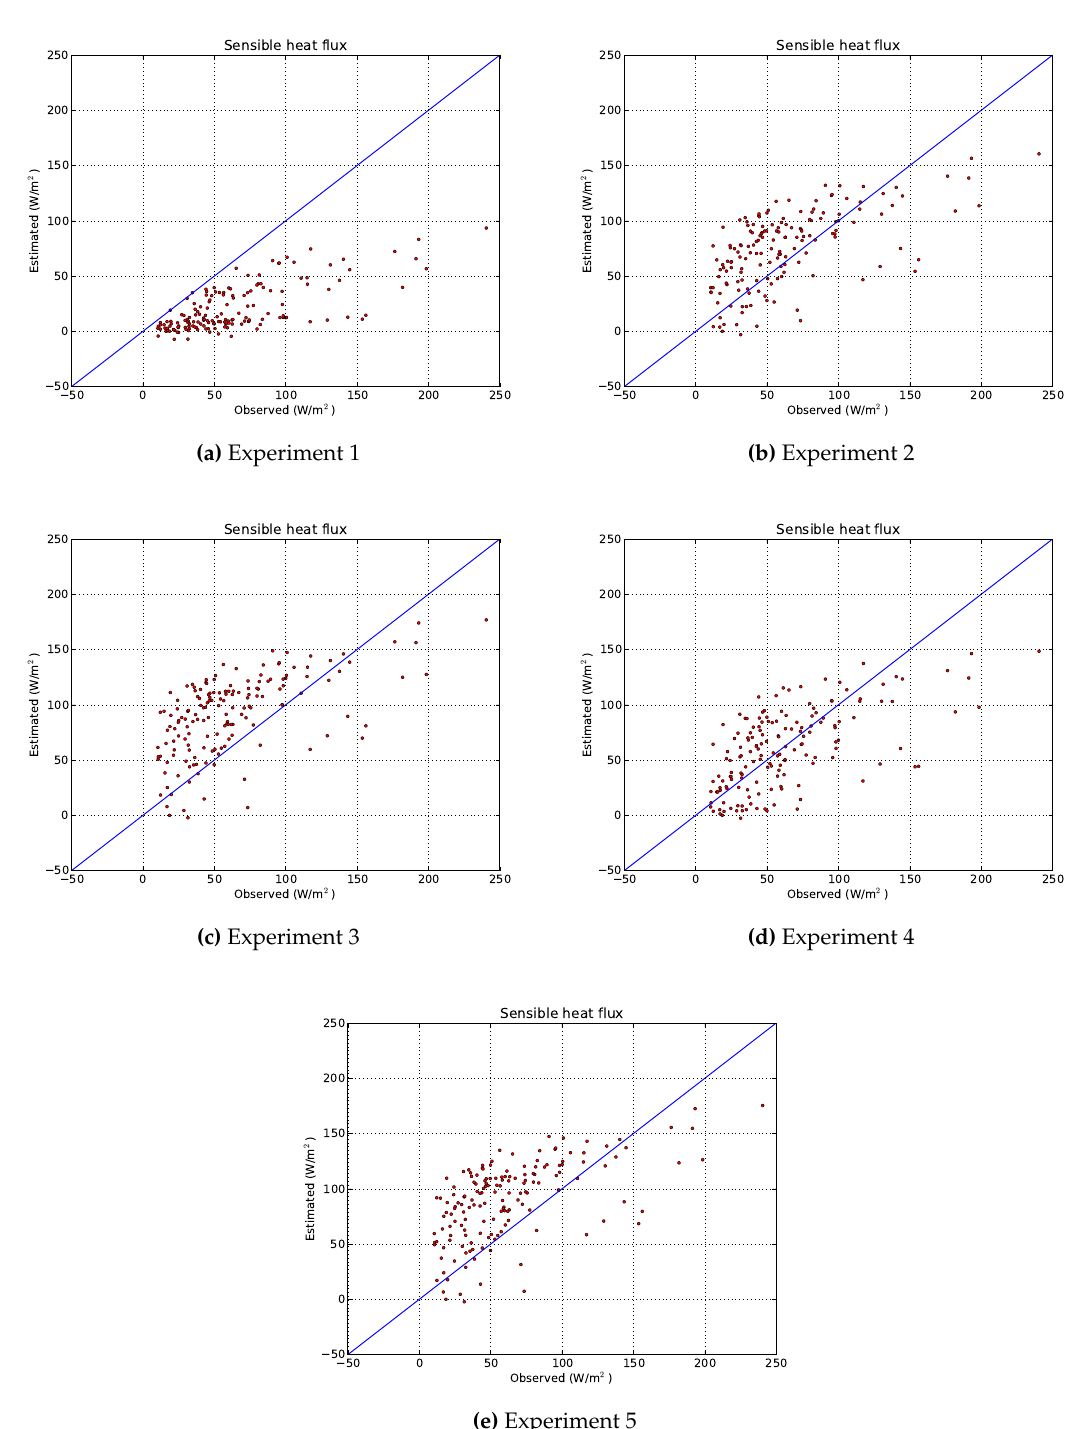
Figure 11. Scatter plots of measured and estimated sensible heat flux for ( a ) experiment 1, ( b ) experiment 2, ( c ) experiment 3, ( d ) experiment 4, ( e ) experiment